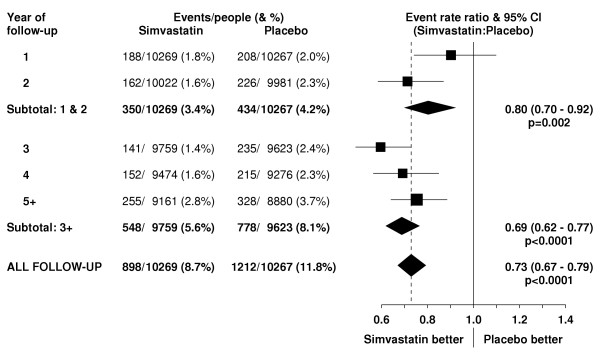
Effect of simvastatin allocation on major coronary events by year of follow-up. Rate ratios (RR: black squares with area proportional to the amount of "statistical information" in each subdivision) comparing outcome among patients allocated simvastatin to that among those allocated placebo are plotted, along with their 95% confidence intervals (CI: horizontal lines). For relevant subtotals, the result and its 95% CI is represented by a diamond, with the overall proportional reduction and statistical significance given alongside. Squares or diamonds to the left of the solid vertical line indicate benefit with simvastatin (with nominal significance of at least two-sided P < 0.05 when the horizontal line or diamond does not overlap the vertical line). The broken vertical lines indicate the overall rate ratios.